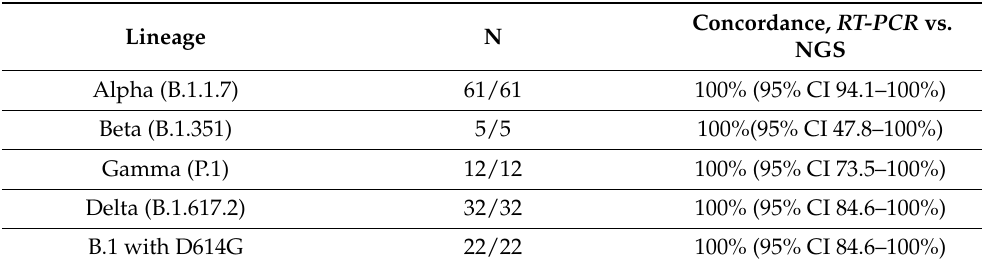
Figure 1. RT-PCR plots for SARS-CoV-2 Alpha variant identification. A sigmoid blue (FAM) curve represents a mutated sequence, whereas a sigmoid green (VIC) curve represents a wild-type sequence (referenced to as a Wuhan sequence). Table 3. Concordance of results of SARS-CoV-2 variant characterization between TaqMan probe RT-PCR and NGS